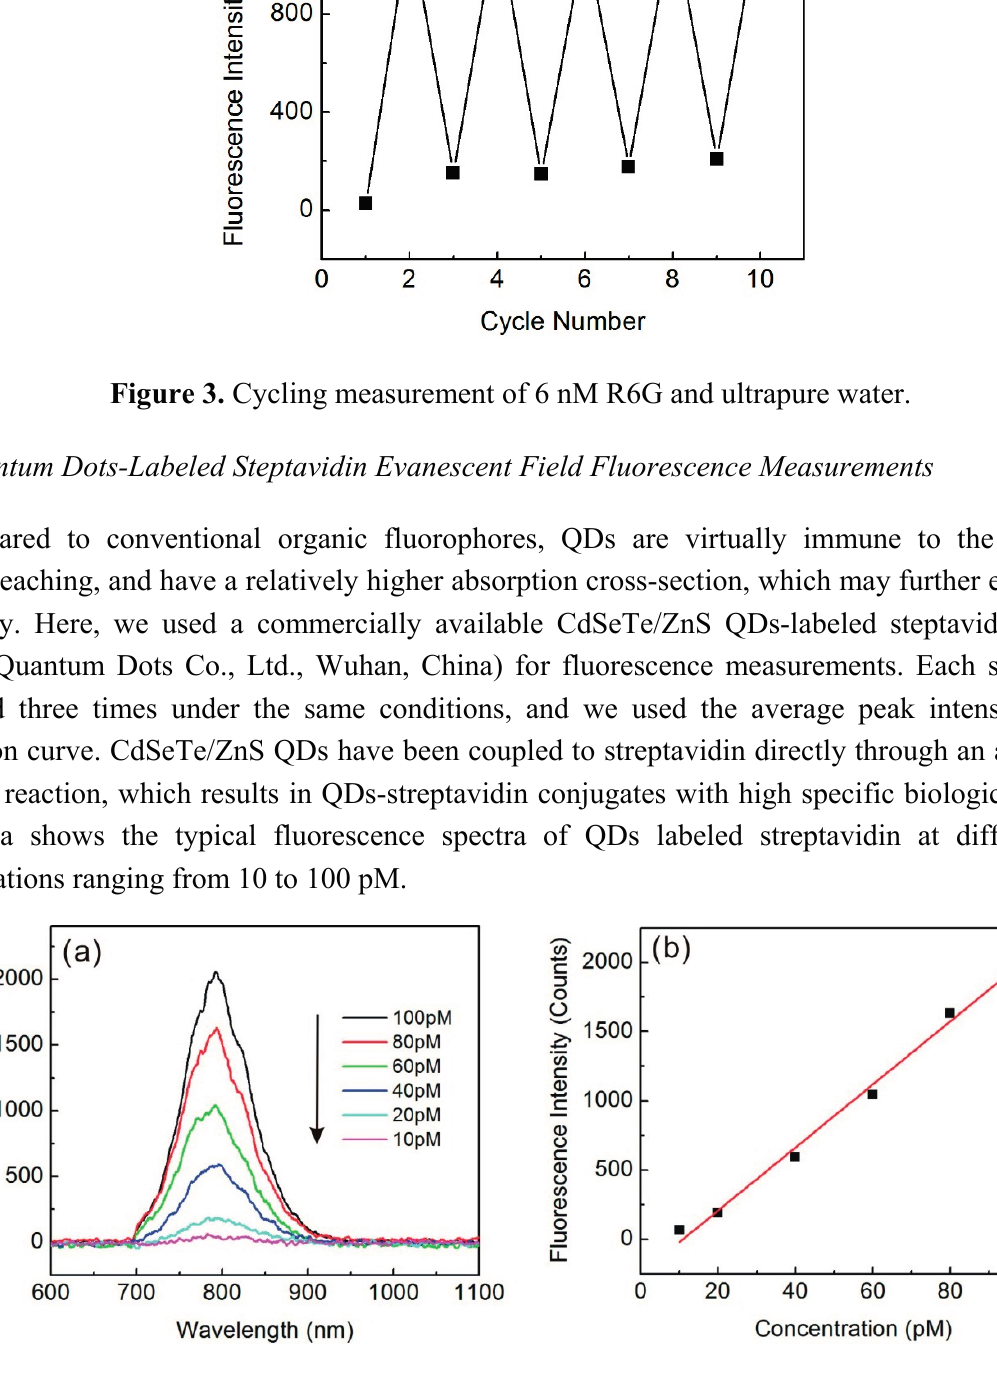
Figure 4. ( a ) Fluorescence spectra of QDs-labeled streptavidin at different QDs concentrations; ( b ) Fluorescence peak intensity as a function of QDs